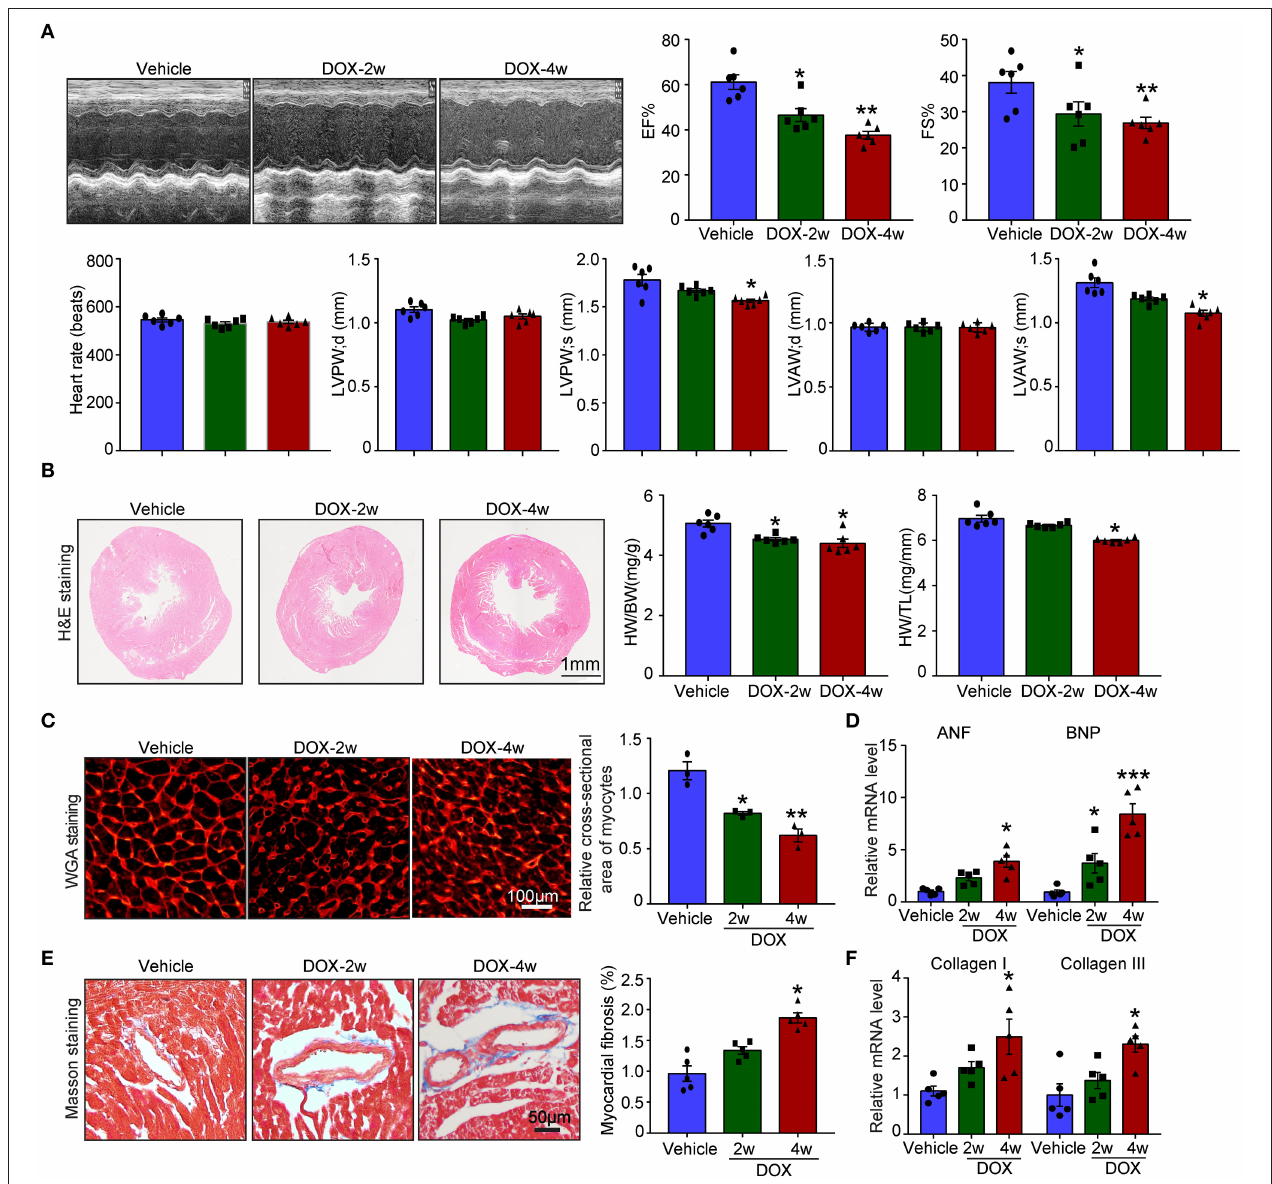
FIGURE 1 | Doxorubicin (DOX) dose-dependently induced cardiac dysfunction and cardiac fibrosis. Mice were intravenously treated with DOX (5 mg/kg) or its solvent once per week for 2 or 4 weeks. (A) Representative M-model echocardiography and the measurement of left ventricular EF% and FS%. The heart rate, left ventricular posterior wall (LVPW), and left ventricular anterior wall (LVAW) at diastole and systole were shown below ( n = 6). (B) Representative image of hematoxylin and eosin (H and E) staining and the HW/BW and HW/TL ratios. Scale bar 1mm. (C) Cardiac myocyte size was evaluated by TRITC-labeled wheat germ agglutinin (WGA) staining, and the cross-sectional area was quantified in the right panel (100 cells counted per heart, n = 3). (D) ANF and BNP mRNA expressions were determined by qRT-PCR in the heart ( n = 5). (E) Cardiac fibrosis was detected by Masson’s trichrome staining, and the relative fibrotic area was quantified ( n = 5, right). Scale bar 50 µ m. (F) The collagen I and collagen III mRNA levels in the heart ( n = 5). Data are presented as mean ± SEM, and n represents the number of animals per group. * p < 0.05, ** p < 0.01, *** p < 0.001 vs.